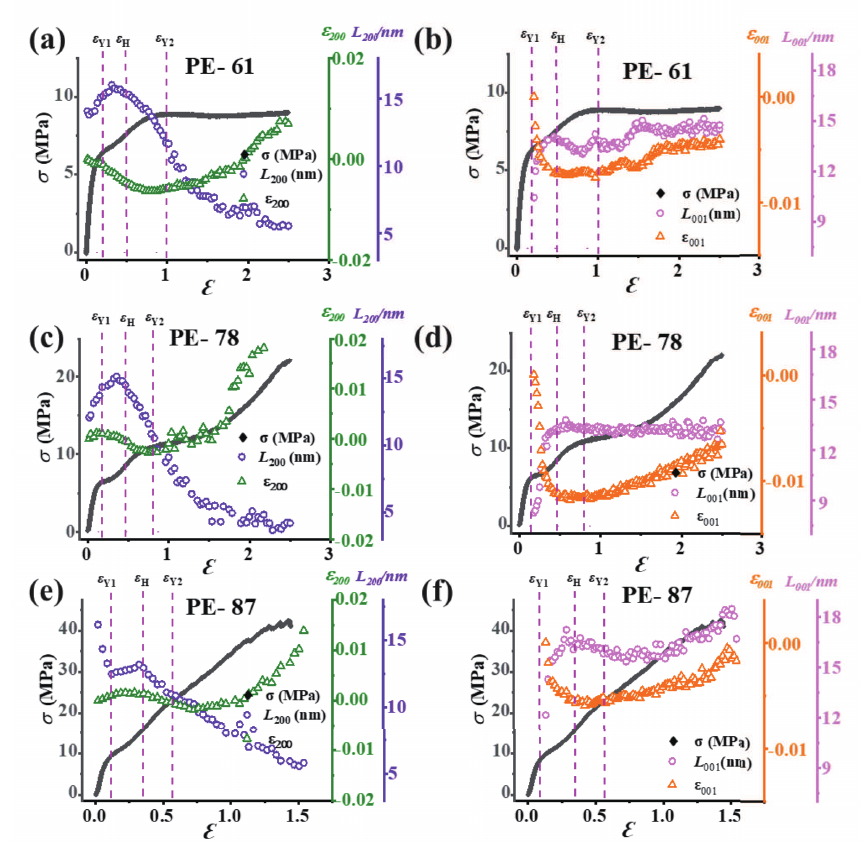
Figure 6. The lateral size and the micro-strain of the ( 200 ) the ( 001 ) M crystallographic plane ( b , d , f ) for different mLLDPE precursor films. The engineering stress–strain curves are also drawn to link the mechanical behavior with